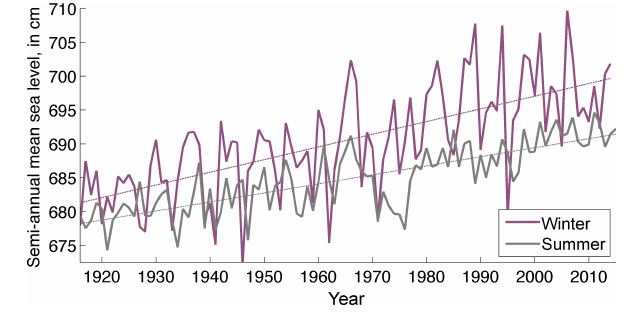
Figure 3. Evolution of winter and summer half-year mean sea lev- els at Den Helder and corresponding trends from linear regression. See also Table 1 for the slope and confidence interval of the